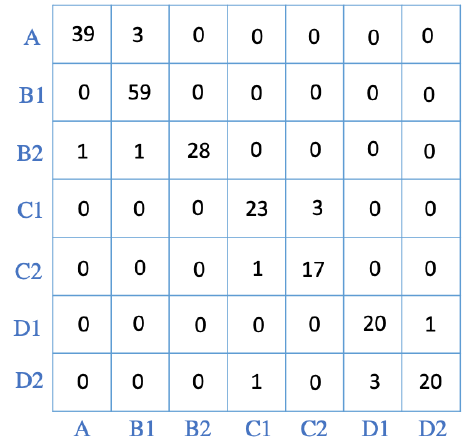
Figure 7. The confusion matrix for the RF model. The classes are consistent with the definition of labels presented in Section